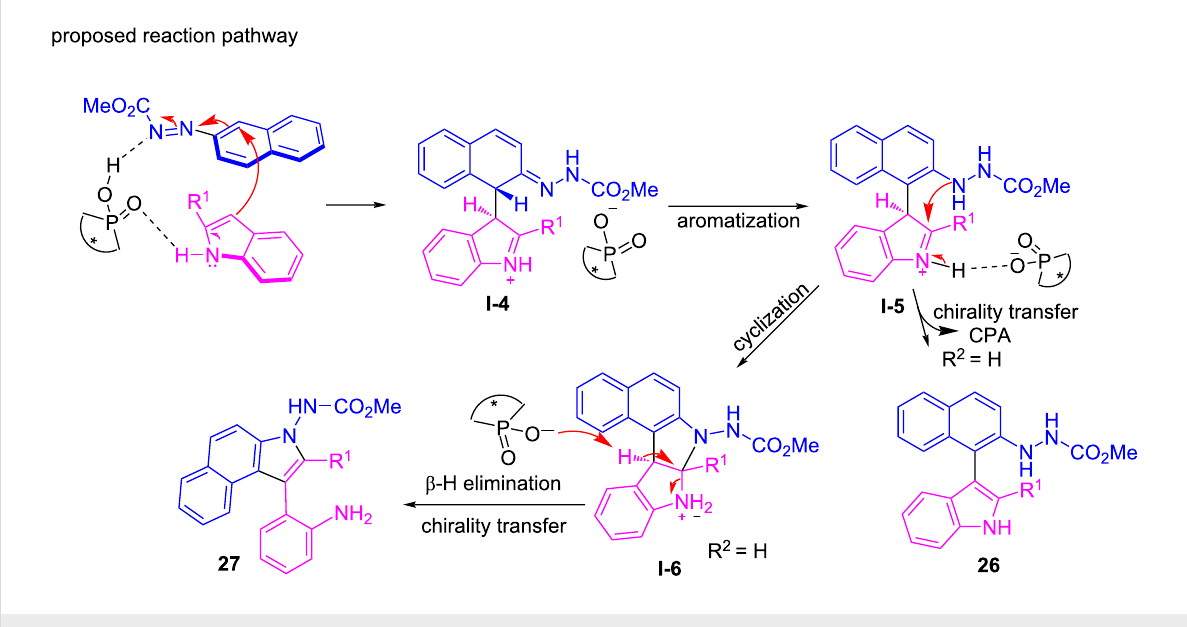
Scheme 10: Proposed mechanism for the asymmetric arylation of